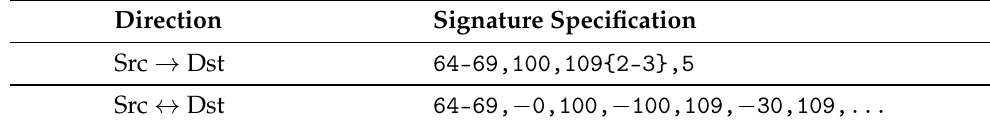
Table 2. Regular-expression-like signature